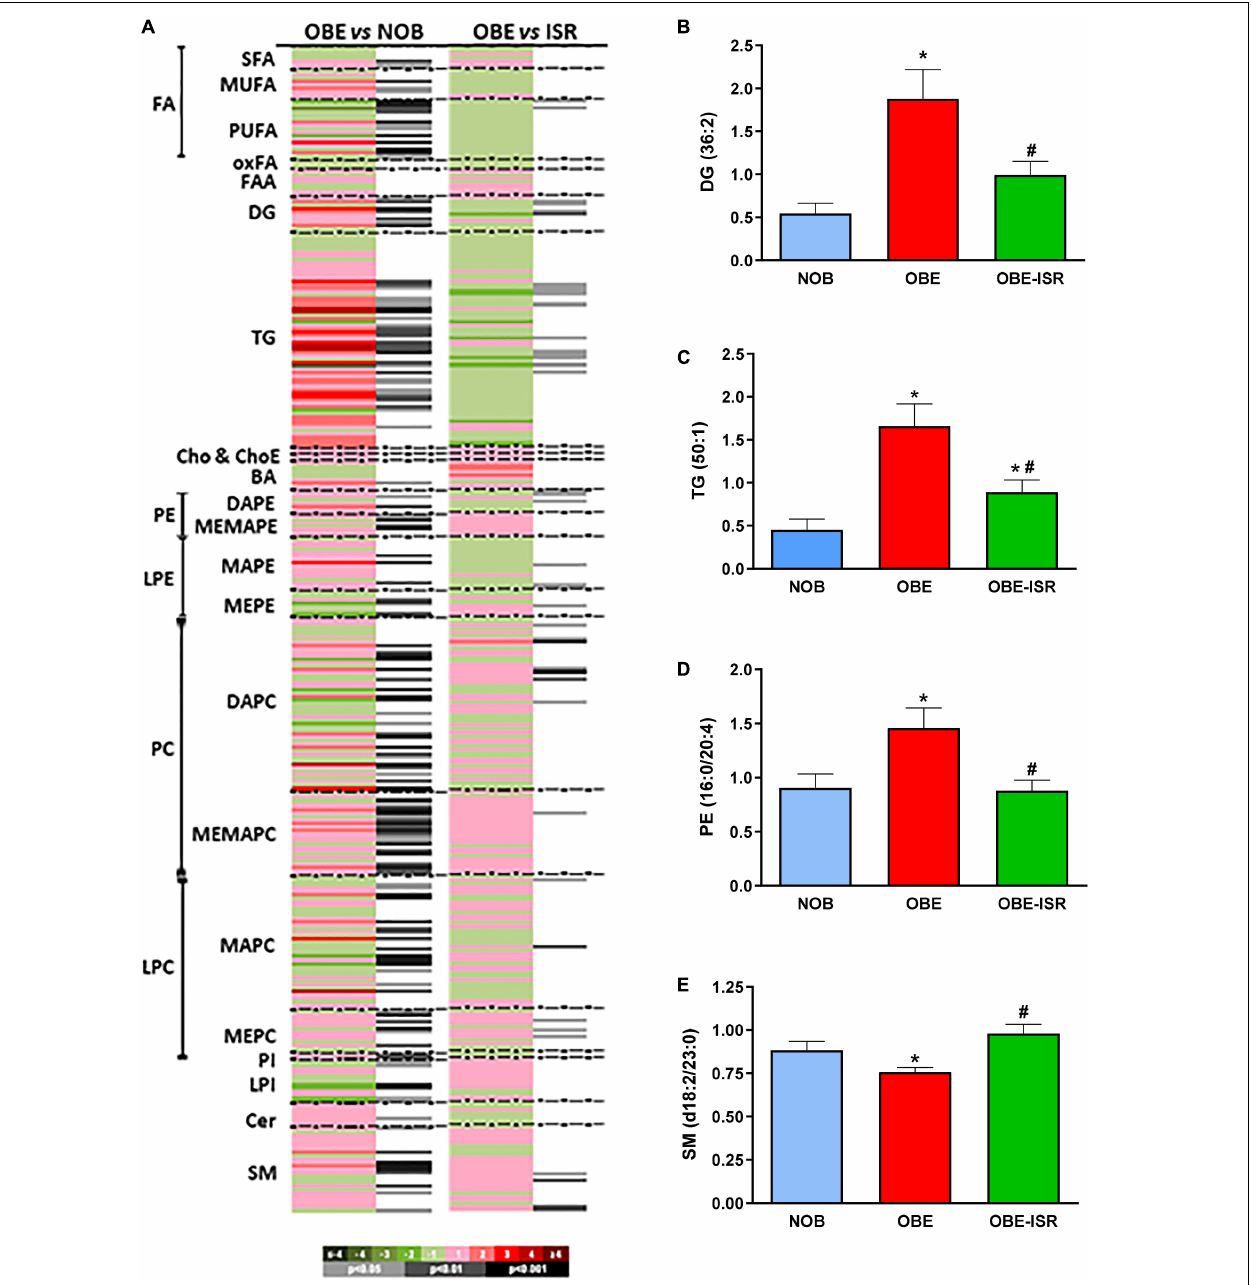
FIGURE 2 | Lipidomic analysis of the plasma in the experimental groups. (A) Heat map showing relevant changes in plasma. Each metabolite is shown as a line whose color is defined by the sign and magnitude of the change. Adjacent column to each comparison shows the results of the t -test. Relevant lipid species of (B) Diacylglycerols, (C) Triglycerides, (D) Phosphatidylethanolamines, (E) Sphingomyelins of the different experimental groups fed on the different experimental diets for 4 weeks to induce obesity. Data expressed as mean ± SEM. *Significant difference with NOB group, p < 0.05. #Significant difference with OBE group, p < 0.05. Cer, ceramides; ChoE, cholesterol esters; DAG, diacylglycerols; FFAox, oxidized free fatty acids; LPC, lysophosphatidylcholines; LPE, lysophosphatidylethanolamines; PC, phosphatidylcholines; PE, phosphatidylethanolamines; PI, phosphatidylinositols; MUFA, monounsaturated fatty acids; PUFA, polyunsaturated fatty acids; SFA, saturated fatty acids; SM, sphingomyelins; TG, triacylglycerols.